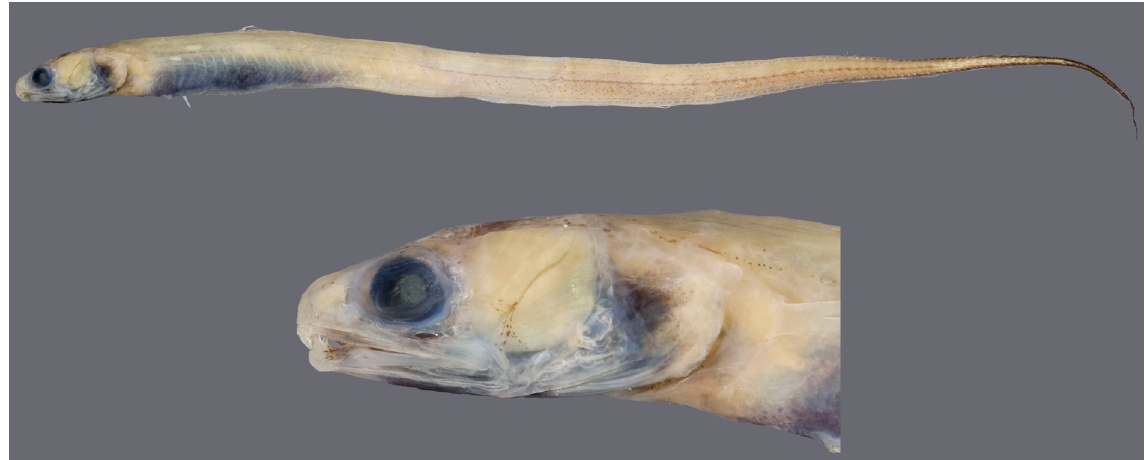
Fig 1. Echiodon prionodon sp. nov., left lateral view (holotype NMNZ P.041833, 165 mm